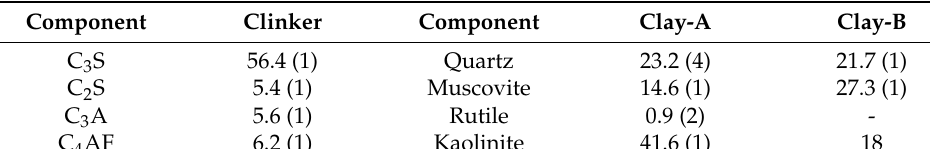
Table 2. Mineralogical composition of clinker and clays.